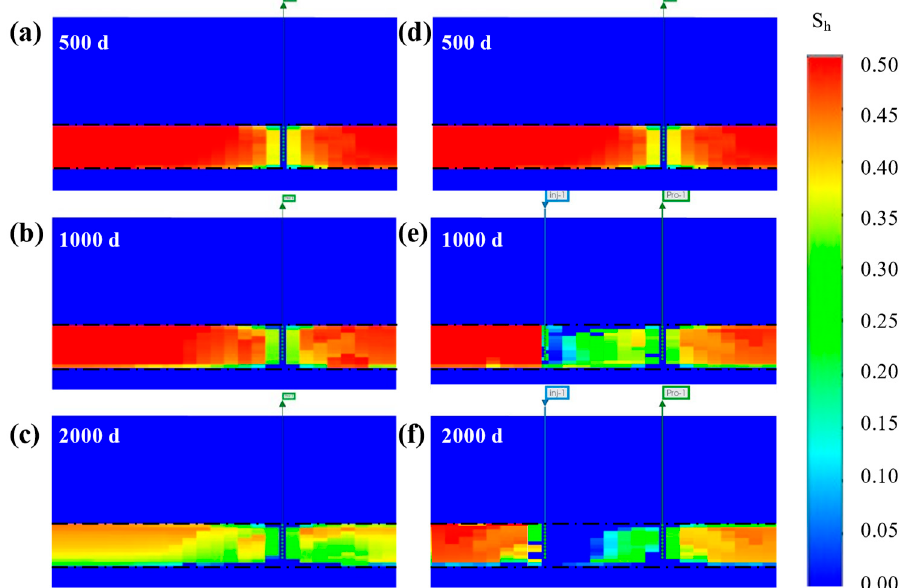
Figure 7. Evolution of NGH saturation after 500 days, 1000 days, 2000 days (( a )–( c ) for Case A and ( d )–( f ) for Case B).